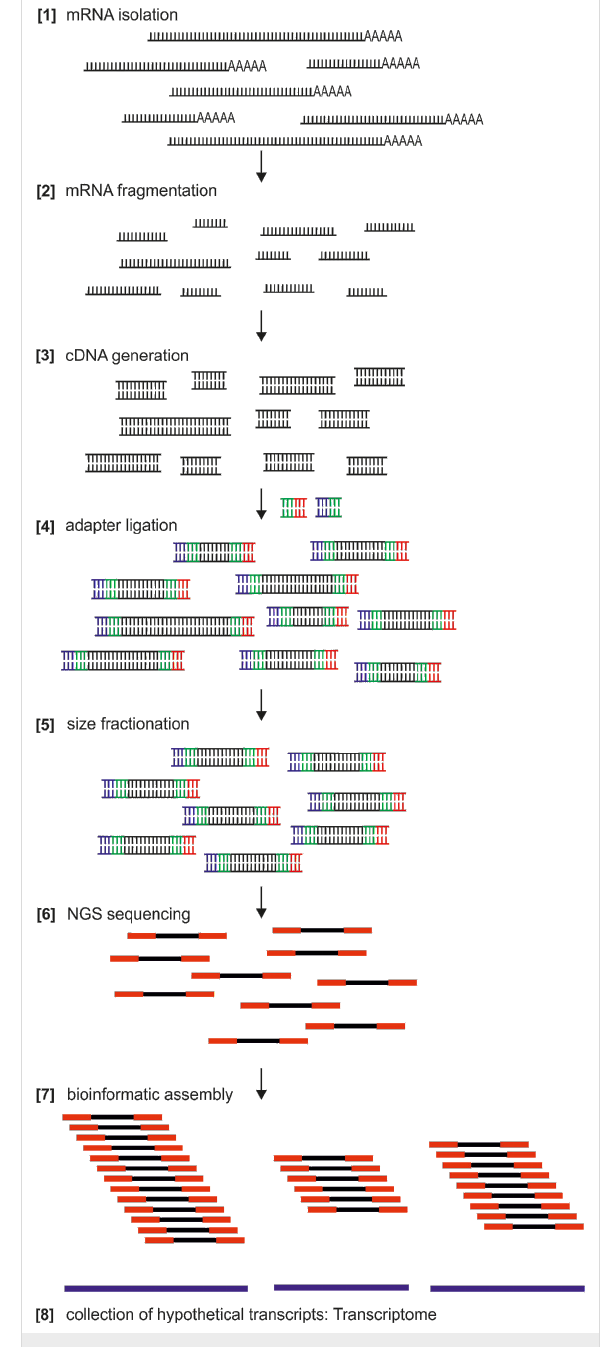
Figure 2: Next generation sequencing (NGS) is a massive sequencing technology, which enables hundreds of gigabases of data to be produced in a single sequencing run. Here, the consecutive steps for the generation of a transcriptome by NGS are illustrated. Depending on the input tissue from which RNA is isolated, a transcriptome of the whole organism or adhesion-related tissue can be generated. See text for